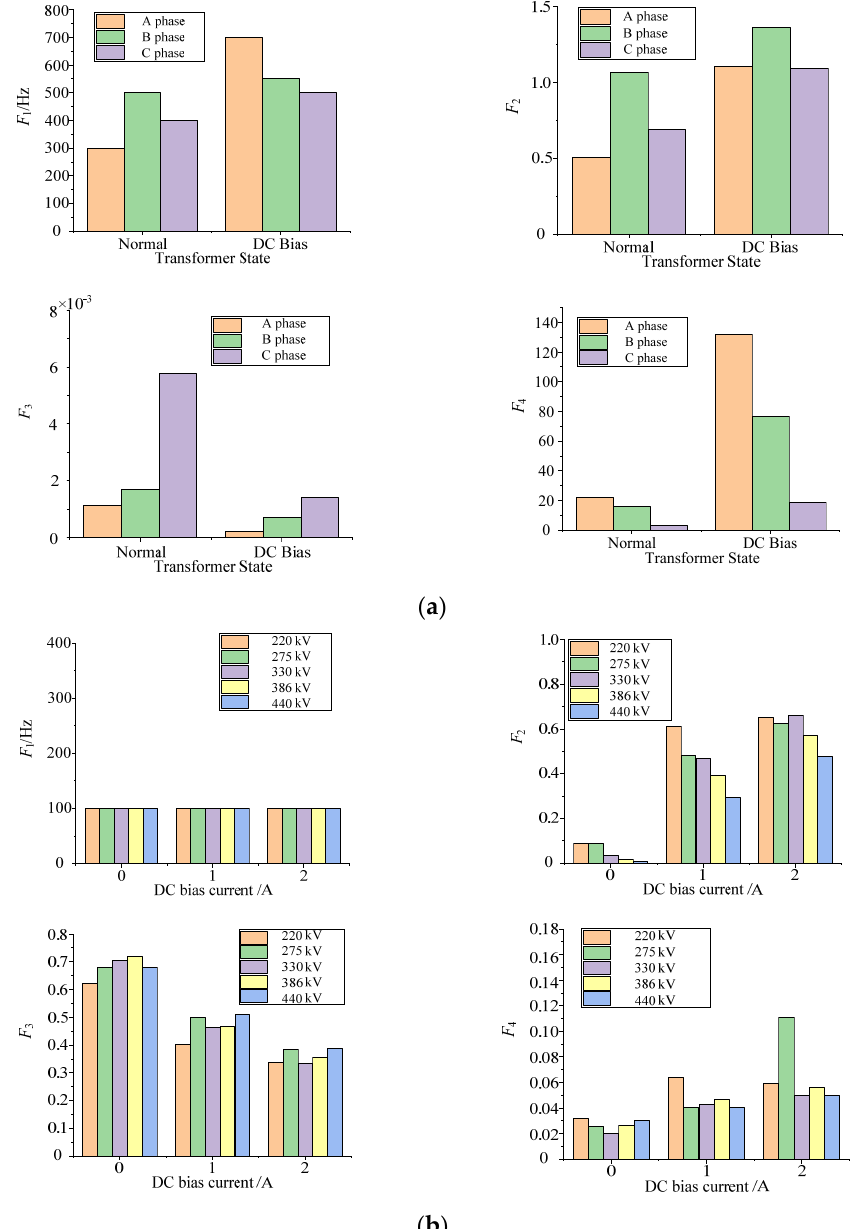
Figure 6. Variation of acoustic signal typical parameters of transformer DC bias. ( a ) 500 kV trans- former. ( b ) Core model.